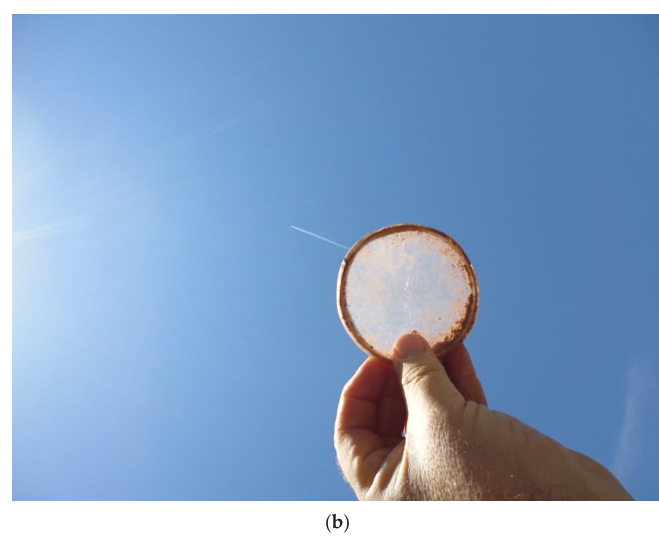
Figure 9. ( a ) Inverted image of container; ( b ) Lid and blue sky.